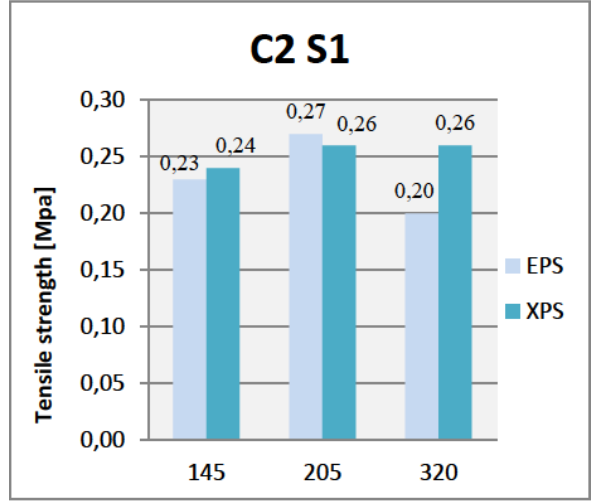
Figure 8: Average results of the pull-off method; comparing the same adhesive C2S1 to different mesh &